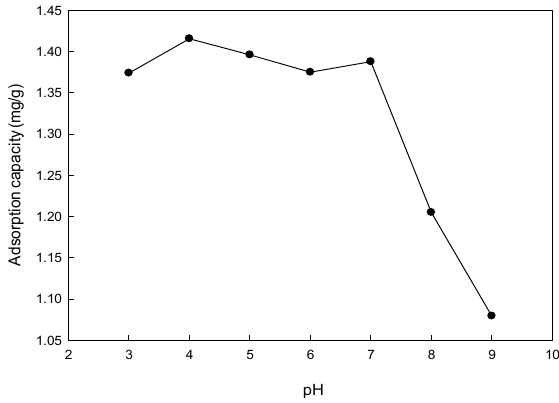
Figure 4: The total adsorption capacity of sulfonamides under different